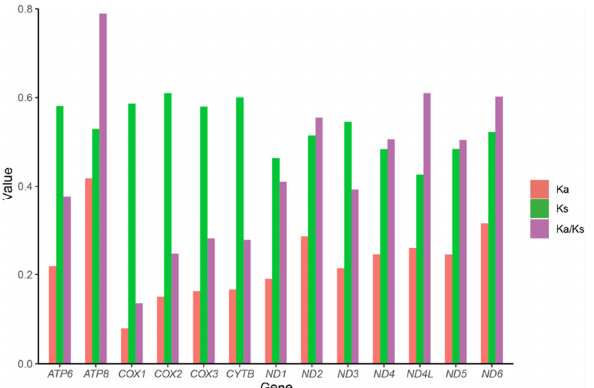
Figure 3. Evolution rate of each protein-coding gene of the hydropsychid mitogenomes. Ka refers to non-synonymous substitution rate, Ks refers to synonymous substitution rate, and Ka/Ks ratio to evolution rate of each protein-coding gene.